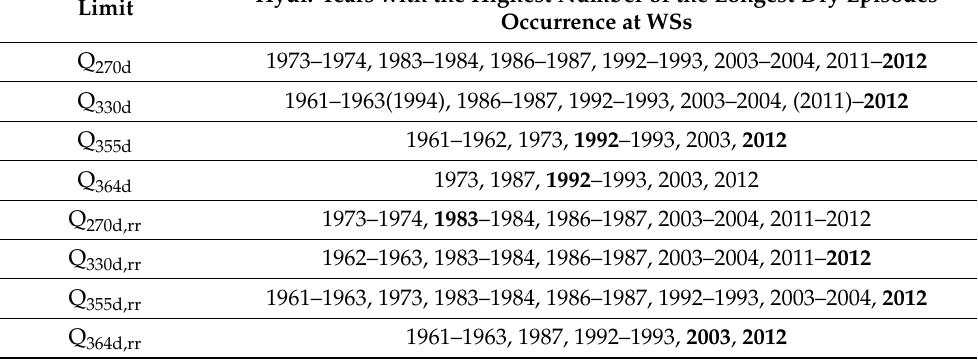
Table 5. The driest hydrological years according to the sum of the occurrence of the five longest dry events at each events at each WS.